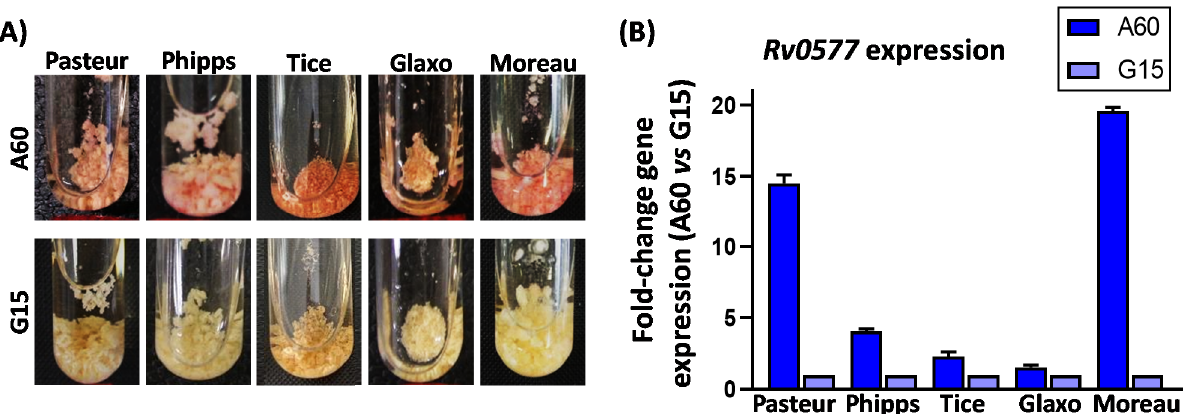
Figure 2. Neutral red staining and Rv0577 gene expression of BCG substrains. ( A ) Images corre- sponding to neutral red staining in cells of BCG substrains grown on different culture media. ( B ) Fold change of Rv0577 expression in BCG substrains grown on A60 medium relative to that of BCG substrains grown on G15 medium. Two independent pellicles for each condition were analyzed.